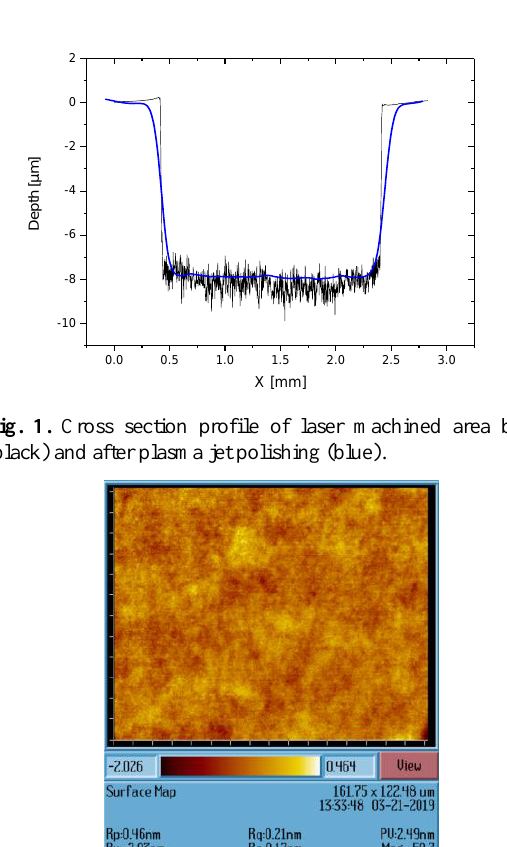
Fig. 2. Micro-roughness on plasma polished surface.